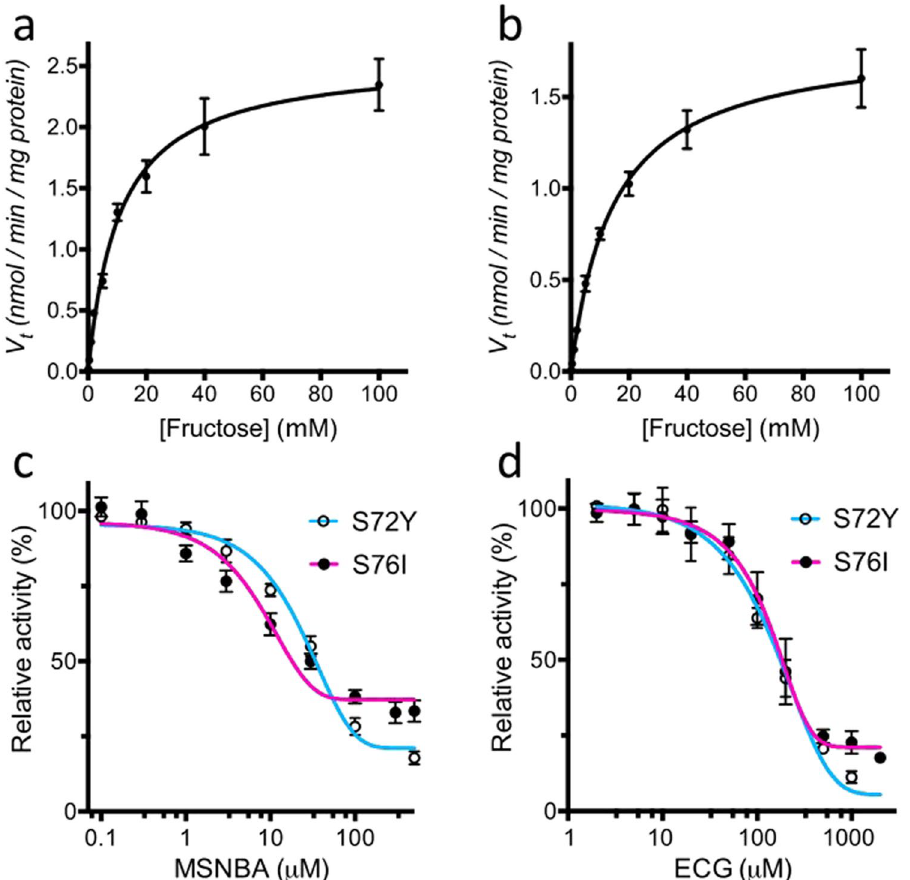
Figure 4. Transport kinetics and inhibition of GLUT5 mutants in hxt 0 cells. The initial uptake velocity v t (expressed as nmol fructose transported per minute per mg cell dry weight) was measured for GLUT5tr S72Y ( a ) and GLUT5tr S76I ( b ) and plotted against sugar concentration. Mean values and standard deviation were calculated from biological triplicates. The lines represent a least-square fit to the Michaelis-Menten equation. The uptake of fructose was measured at variable MSNBA ( c ) and ECG ( d ) concentrations and the uptake velocity was normalized to that in the absence of the inhibitor. The IC 50 values were calculated by nonlinear algorithm plots supplied by Prism (GraphPad Software).